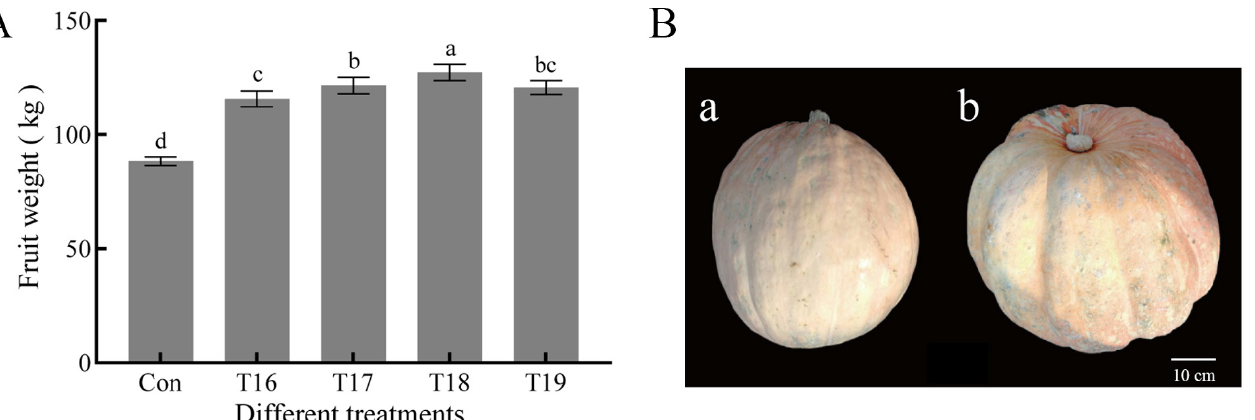
Figure 1. Effects of different concentrations of NAA and EBR on the fruit weight of giant pumpkin. Different lowercase letters on the bars indicate significant difference ( p -value < 0.05). Con: control; giant pumpkin leaves and fruits sprayed distilled water (Tween-20 with a volume fraction of 0.1%), and “Con” represented the same meaning as the following. T: growth regulator treatment, giant pumpkin leaves and fruits sprayed with NAA and EBR, and the details of T1–14 combination are listed in Section 4.